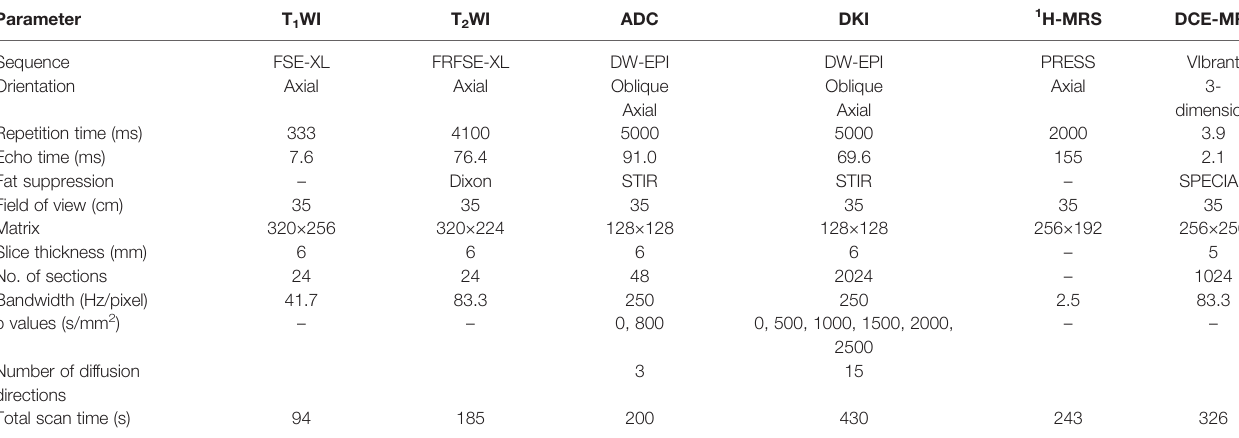
TABLE 1 | Imaging protocol parameters for T 1 WI, T 2 WI, DWI, DKI, 1 H-MRS and DCE-MRI.